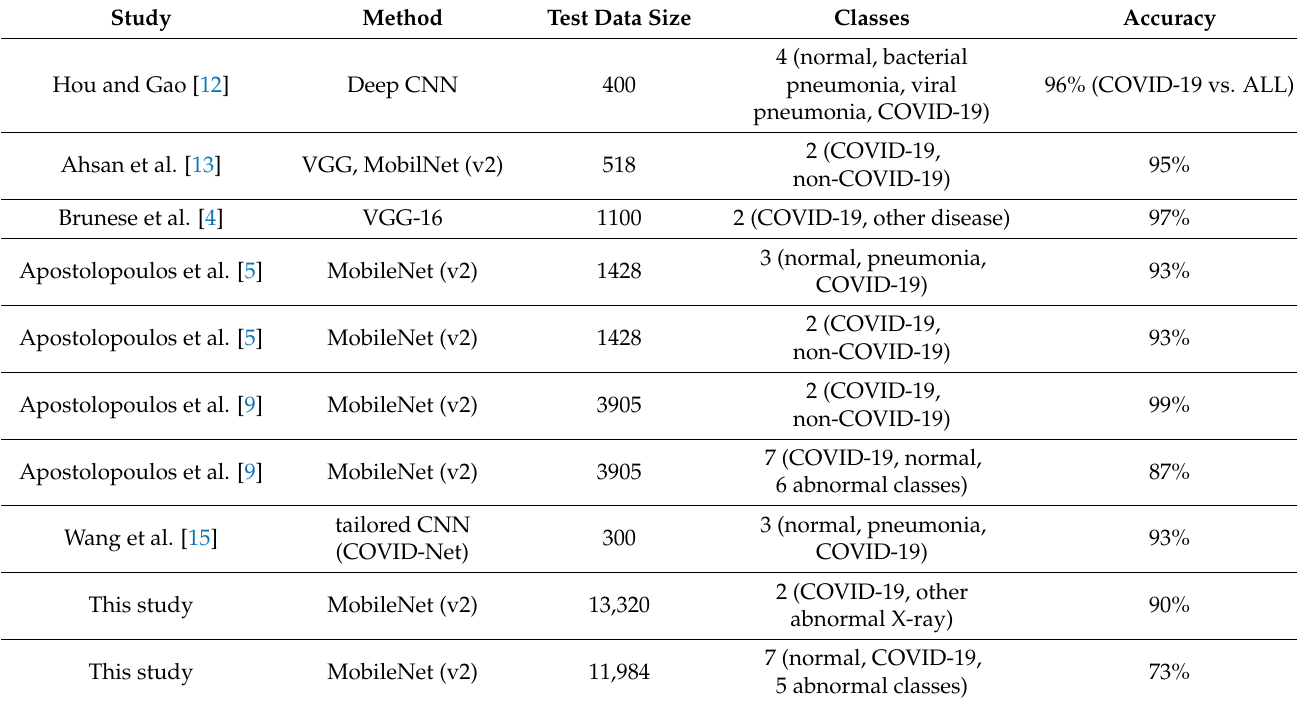
Table 6. Comparison with related